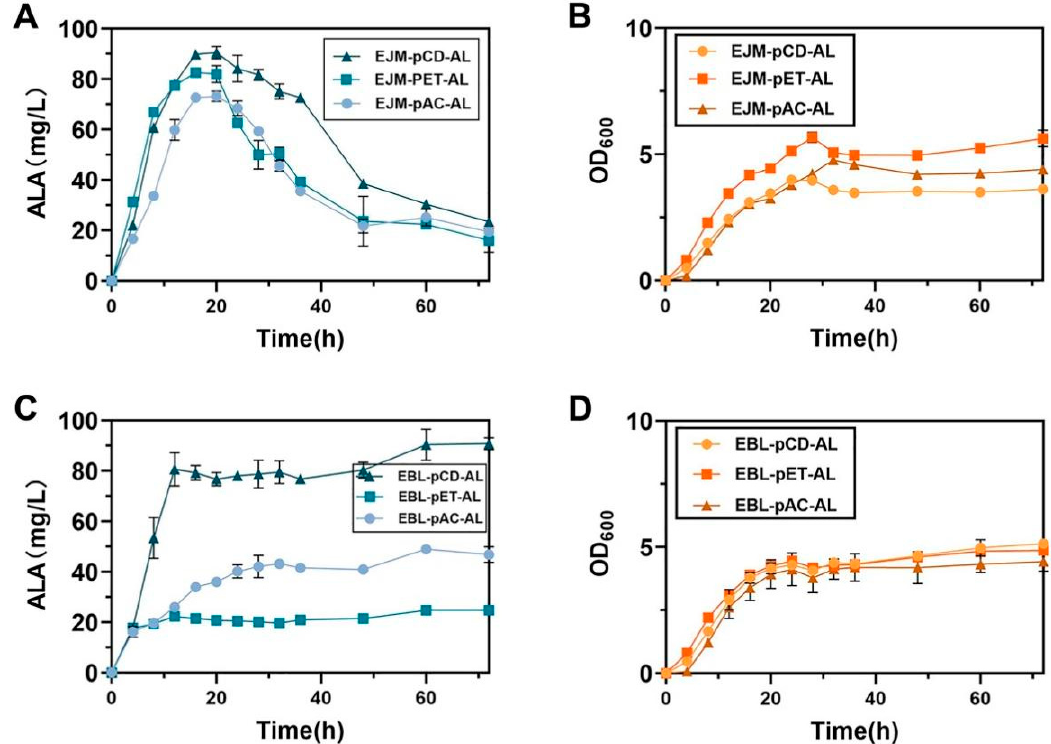
Figure 3. ( A ) The recombinant plasmids pCD- hemA - hemL , pET- hemA - hemL and pAC- hemA - hemL were transformed into the host E. coli JM109(DE3) for ALA production after 72 h of fermentation. ( B ) Growth curves of recombinant plasmids pCD- hemA - hemL , pET- hemA - hemL and pAC- hemA - hemL were transformed into the host E. coli JM109(DE3) for 72 h fermentation. ( C ) The recombinant plasmids pCD- hemA - hemL , pET- hemA - hemL and pAC- hemA - hemL were transformed into the host E. coli BL21(DE3) for ALA production after 72 h of fermentation. ( D ) Growth curves of recombinant plasmids pCD- hemA - hemL , pET- hemA - hemL and pAC- hemA - hemL were transformed into the host E. coli BL21(DE3) for 72 h fermentation. All data indicate the mean of two independent biological experiments and error bars represent standard deviation.